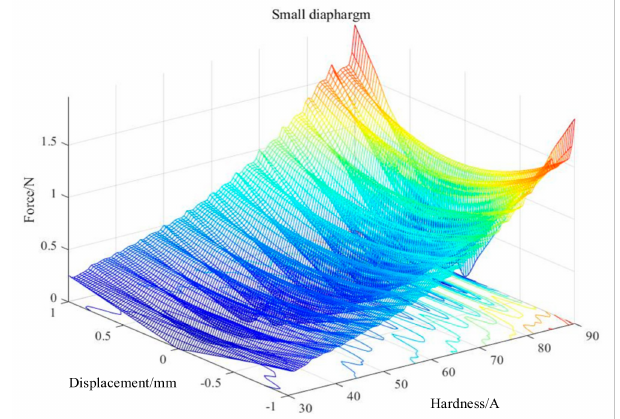
Figure 13. Movement resistance of small